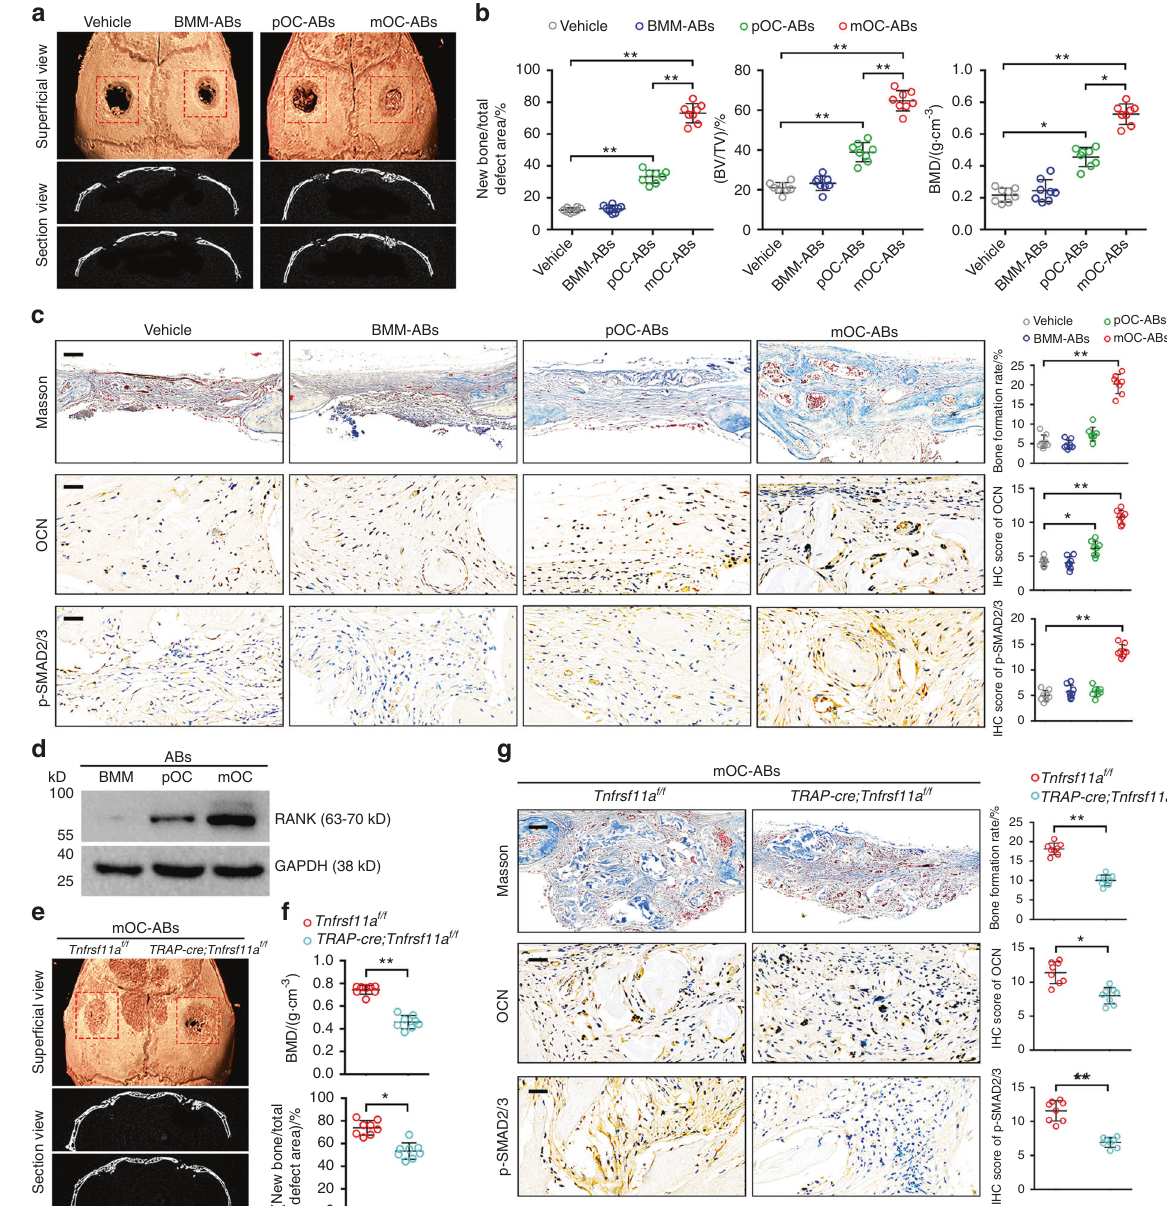
Fig. 6 mOC-ABs promote osteogenesis through RANKL reverse signaling. a Representative micro-CT images of cranial bone 4 weeks after AB- DBM implantation. b Quanti fi cation of bone histomorphometric parameters (bone formation ratio, bone volume density (BV/TV), bone mineral density (BMD)) based on micro-CT images, n = 8. c Representative histological images of Masson staining and IHC of OCN and p-SMAD2/3 in mouse cranial bone sections (left). Quanti fi cation of the bone formation ratio and semiquantitative analysis of OCN and p-SMAD2/3 levels in mice grafted with AB-DBM (right). The scale bars represent 300 μ m for Masson staining and 70 μ m for IHC staining, n = 8. d Western blot analysis of RANK levels in different ABs. As shown, RANK was included in the proteomic signature of mOC-ABs. e Representative micro-CT images of cranial bone treated with TRAP-cre;Tnfrsf11a f/f mOC-ABs for 4 weeks. f Quanti fi cation of the amount of new bone formation and BMD in the total DRA of mice treated with TRAP-cre;Tnfrsf11a f/f mOC-ABs based on micro-CT images, n = 8. g Representative histological images of Masson staining and IHC of OCN and p-SMAD2/3 in the indicated groups (left). Semiquantitative analysis of OCN and p-SMAD2/3 levels and the bone formation ratio in the indicated groups (right). The scale bars represent 300 μ m for Masson staining and 70 μ m for IHC staining, n = 8. The data in the fi gures are presented as the average ± SD values. Statistically signi fi cant differences between the treatment and control groups are indicated as * ( P < 0.05) or ** ( P < 0.01)